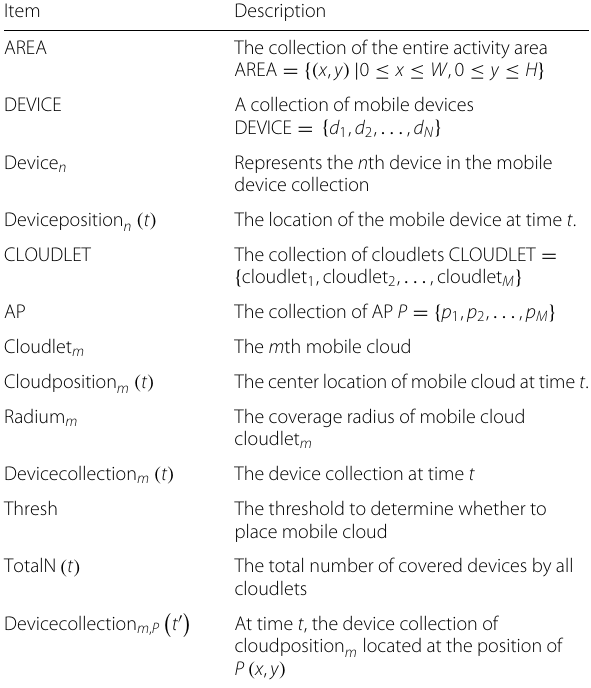
Table 1 Key parameters and